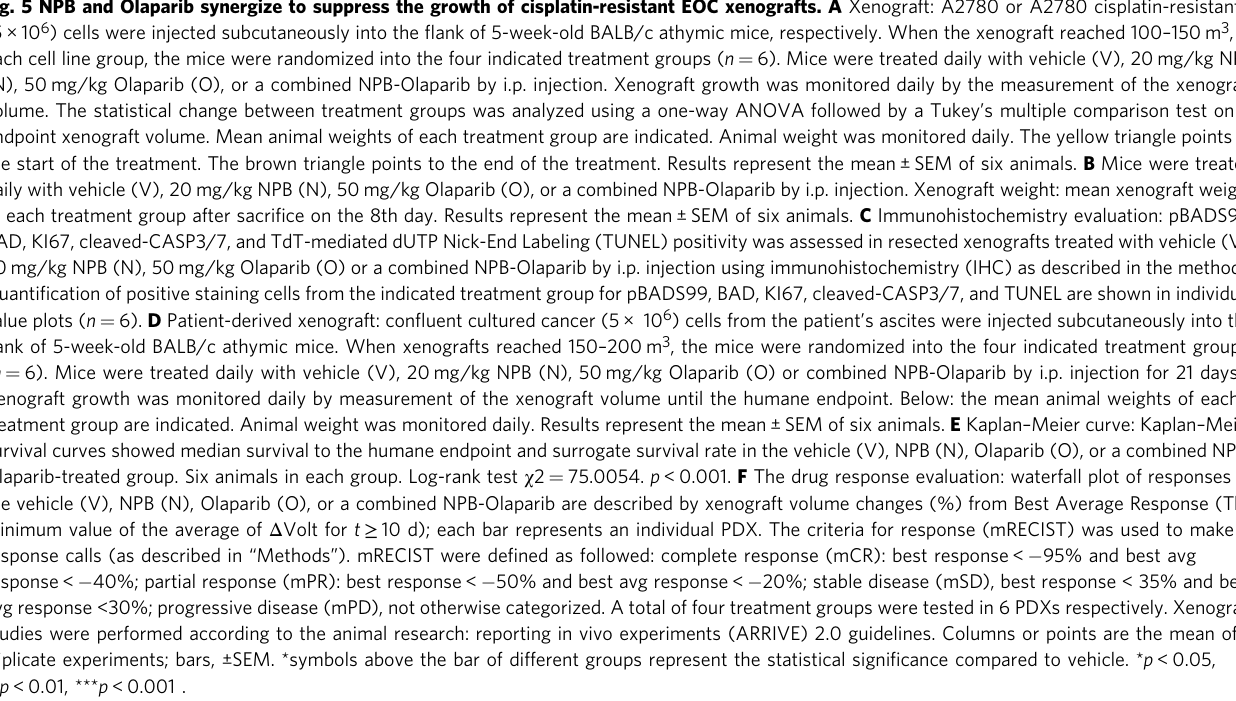
studies were performed according to the animal research: reporting in vivo experiments (ARRIVE) 2.0 guidelines. Columns or points are the mean of triplicate experiments; bars, ±SEM. *symbols above the bar of different groups represent the statistical signi fi cance compared to vehicle. * p < 0.05, ** p < 0.01, *** p < 0.001